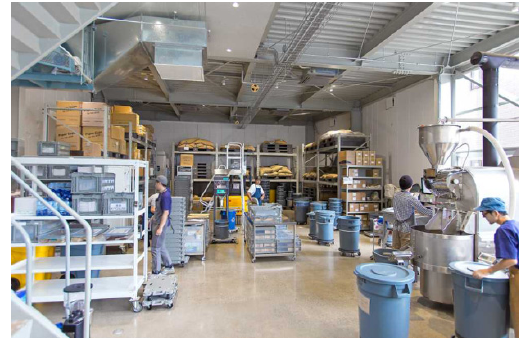
Figure 35. Blue Bottle in Kiyosumi.